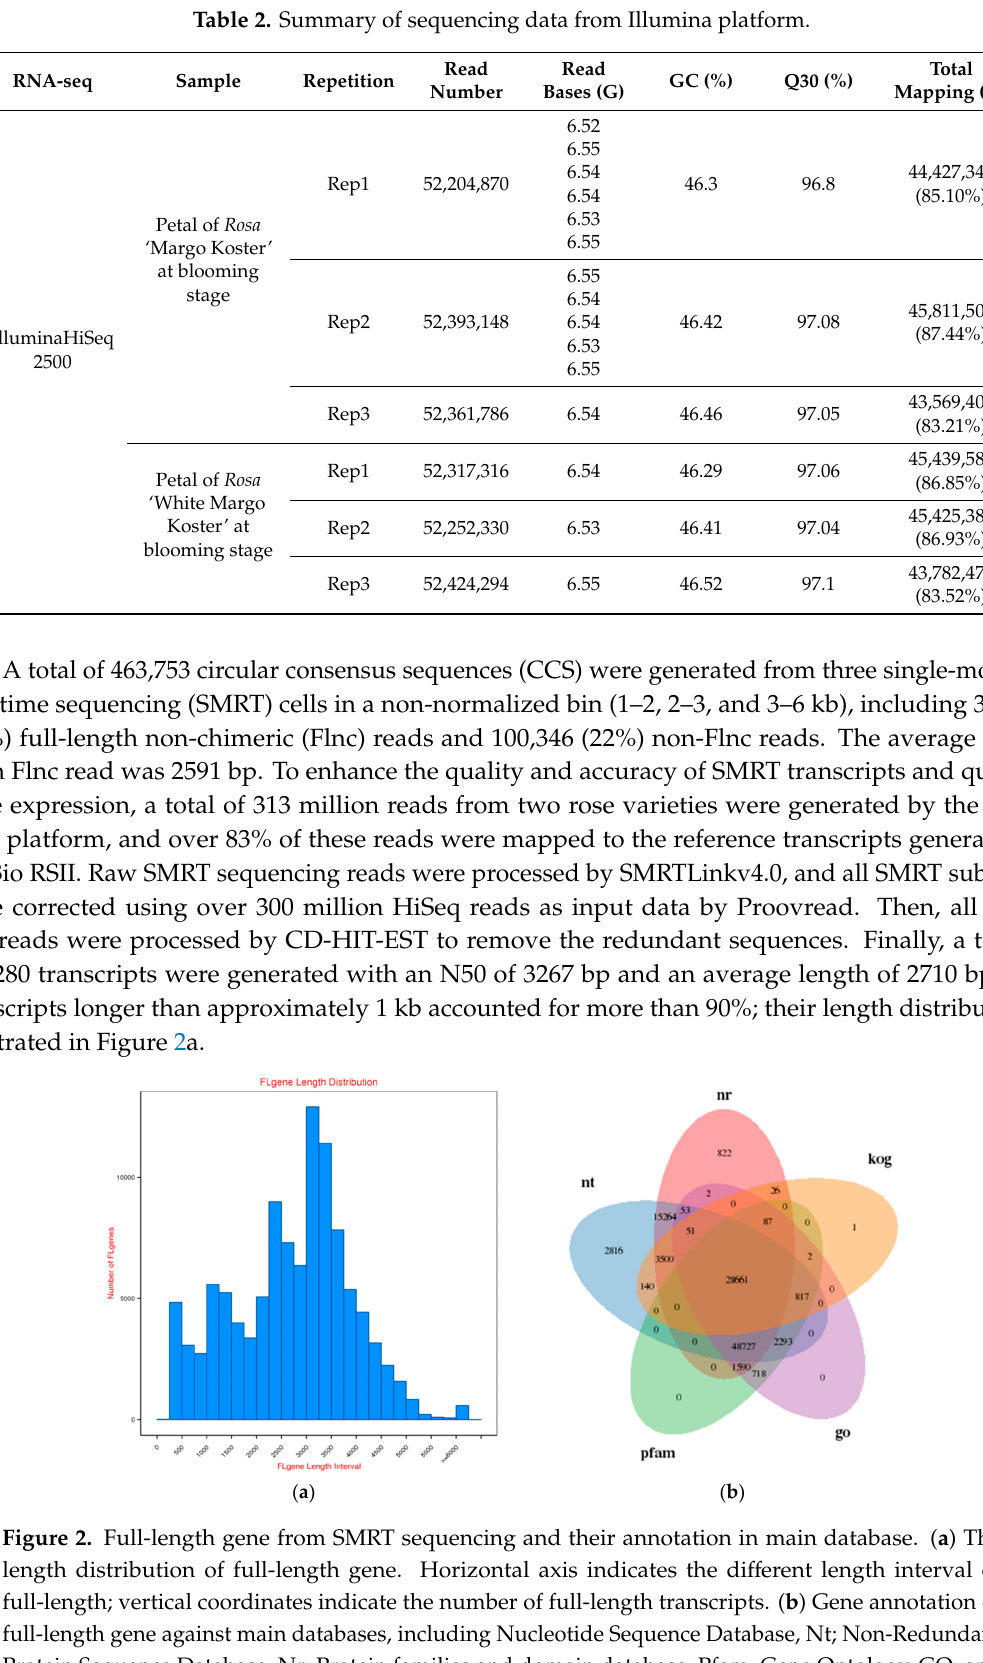
Table 2. Summary of sequencing data from Illumina platform.